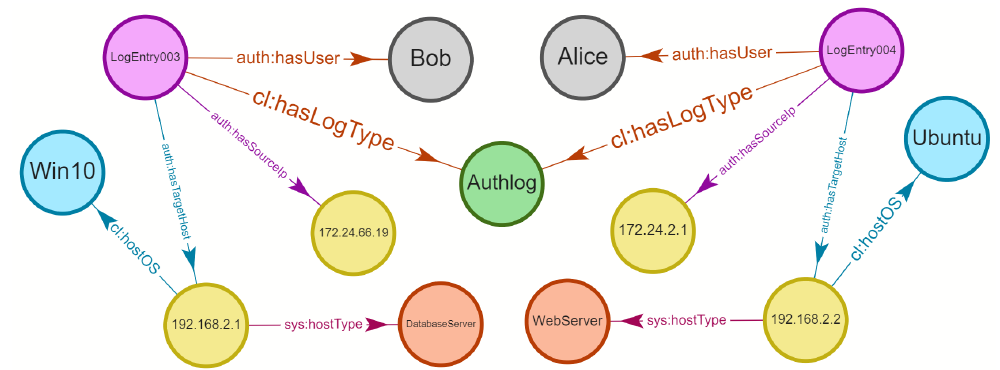
Figure 9. SSH connections query result visualization